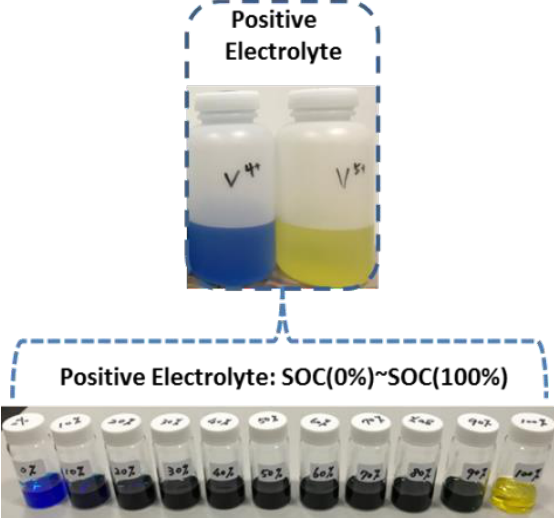
Figure 5. The positive electrolyte couple and electrolyte samples with distinct SOC values.